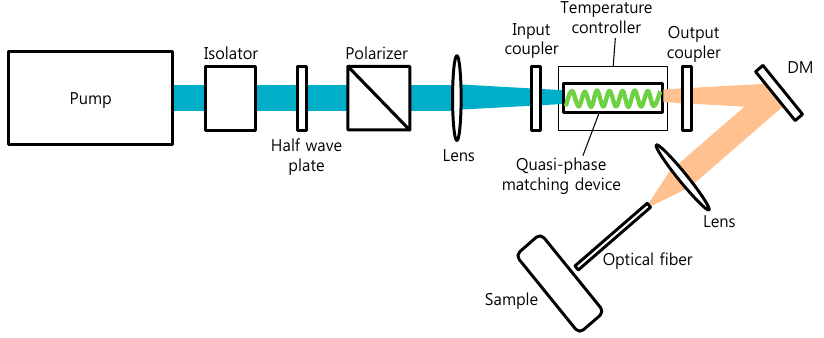
Figure 1. Experimental setup of OPO-based 2 micron generation for tissue ablation. DM: dichroic mirror, Pump: DPSS Nd:YAG laser (1064 nm).